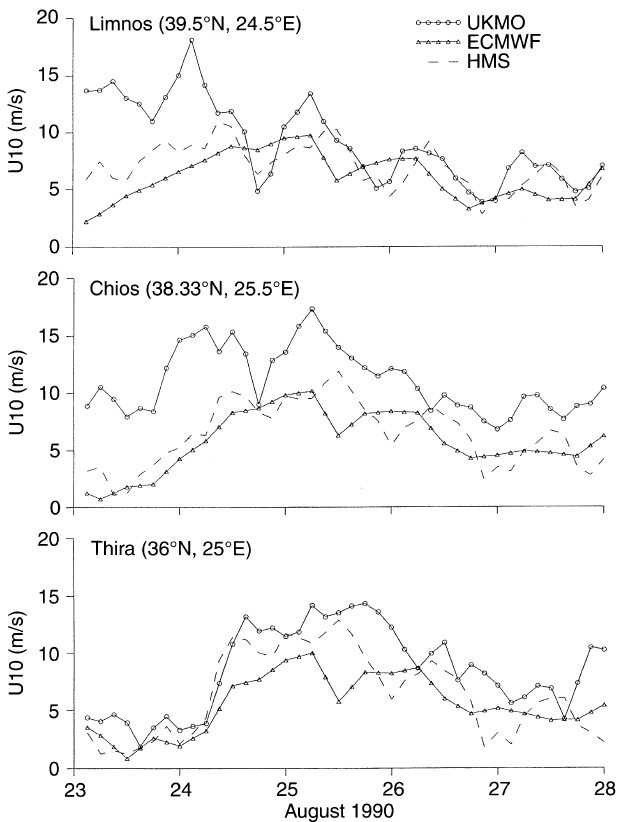
Fig. 7. Wind speed at specific grid points, August 1990 (UKMO v. ECMWF v. HMS)